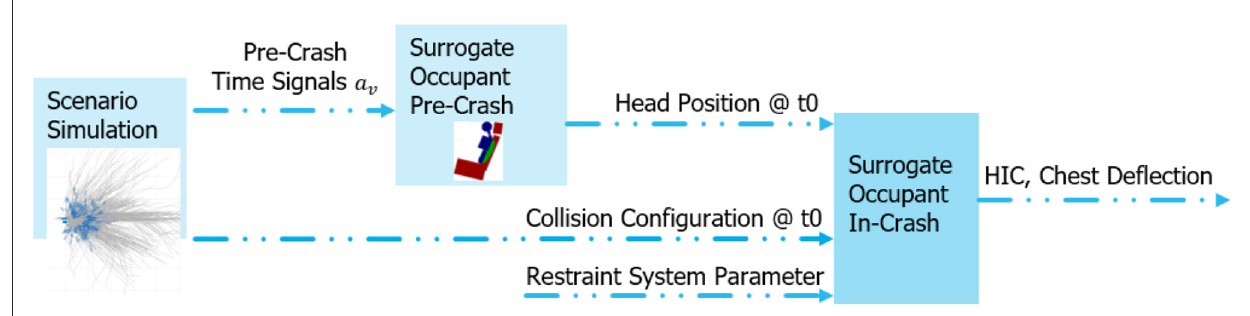
FIGURE3 Surrogate model-enhanced framework for efficient approximation of human body model response based on the driving and collision